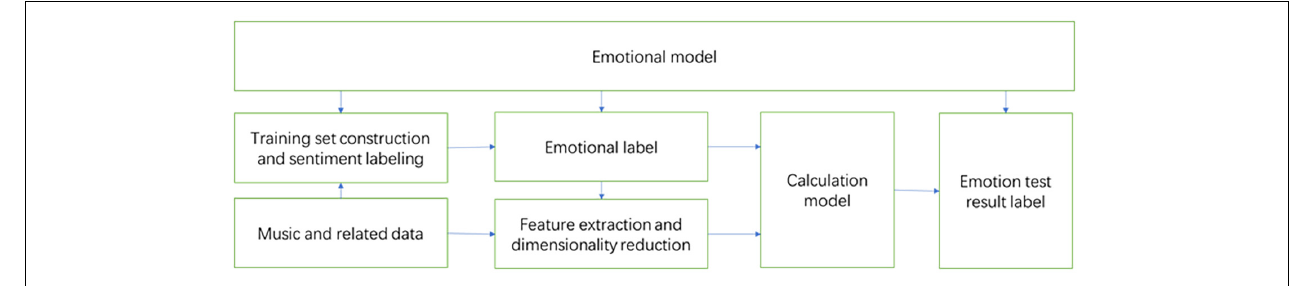
FIGURE 1 | Music emotion recognition